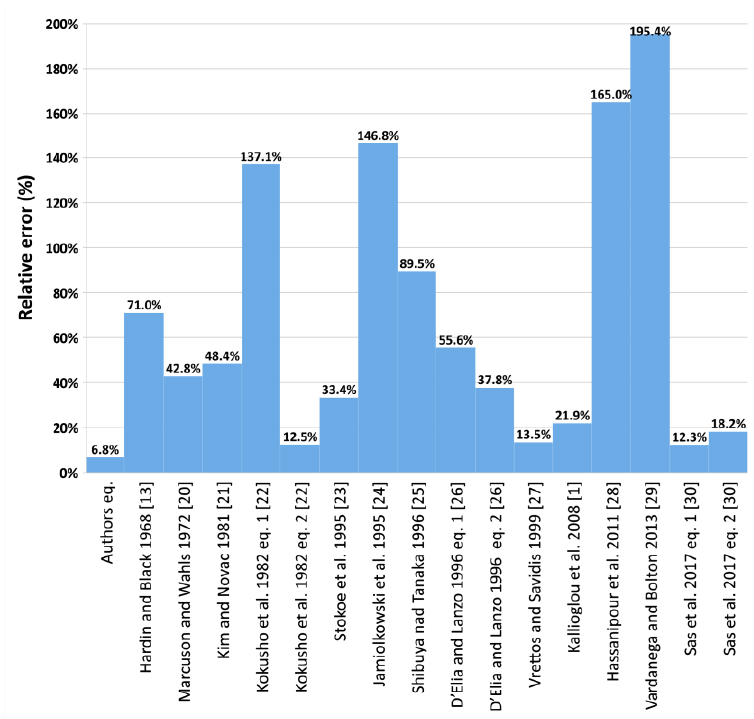
Figure 4. Relative error (%) of the measured to calculated G MAX values by authors’ equation and equation from Table 1.